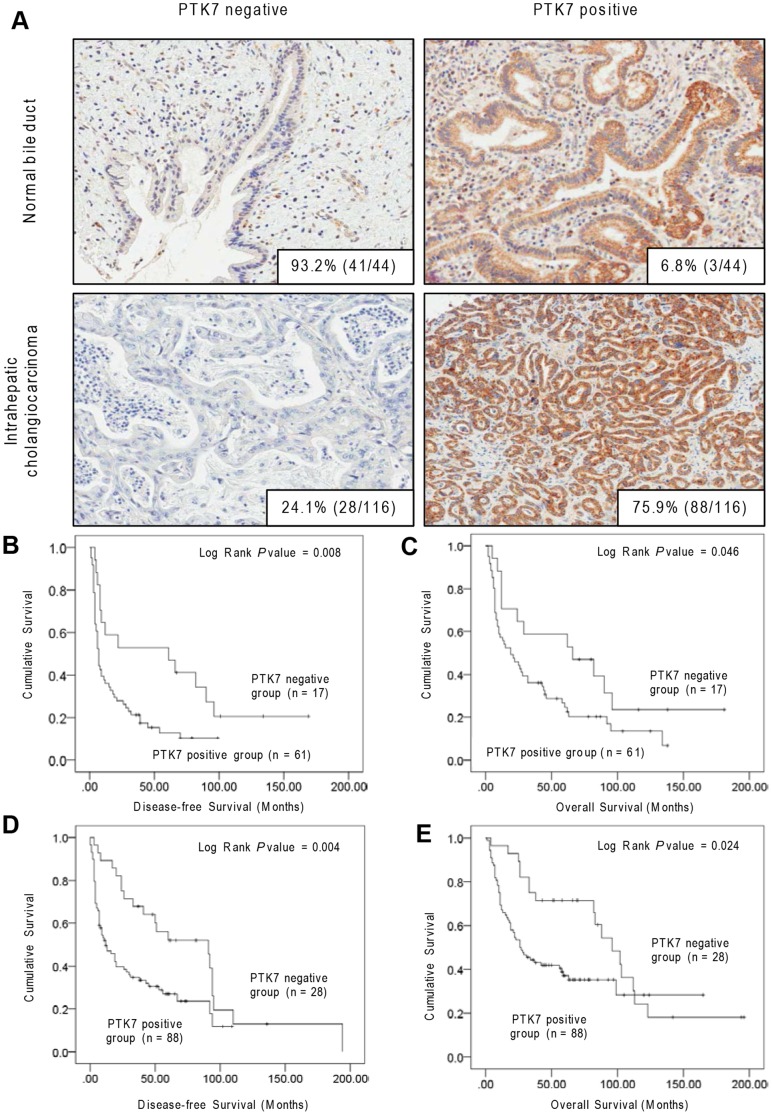
PTK7 expression in human ICC and normal bile duct tissue.(A) PTK7 immunohistochemistry staining for ICC and normal bile duct tissue. In normal bile duct, 93.2% (41/44) of cases stained negatively for PTK7 (upper left), 6.8% (3/44) of cases stained positively for PTK7 (upper right). In ICC, 24.1% (28/116) of cases stained negatively for PTK7 (lower left), 75.9% (88/116) of cases stained positively for PTK7 (lower right) (original magnification, 200×). Kaplan–Meier curves for (B) DFS and (C) OS of patients with positive or negative PTK7 expression in test set, and (D) DFS and (E) OS of validation cohort.